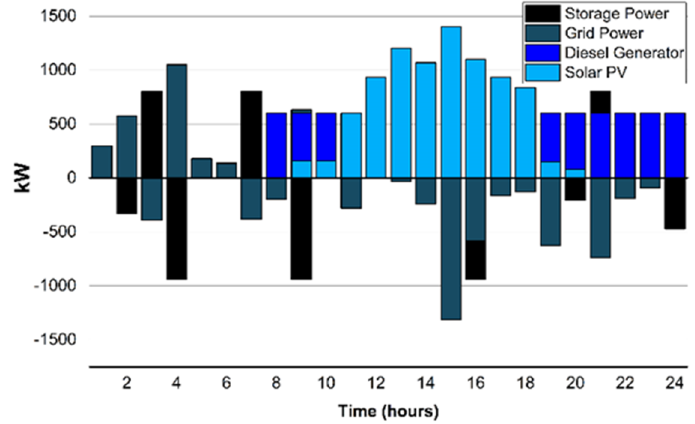
Figure 8. Scenario 1(d): Energy exchange with the grid.